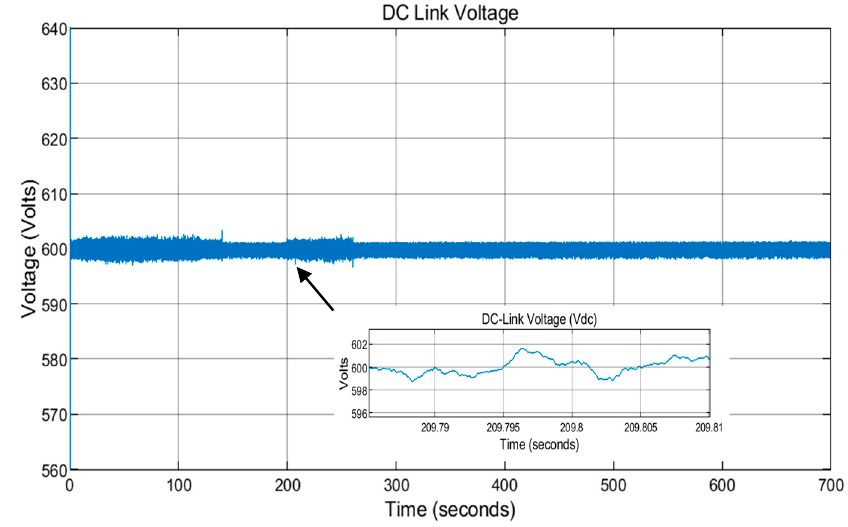
Figure 12. DC-link voltage during different states of operation and variable torque values.